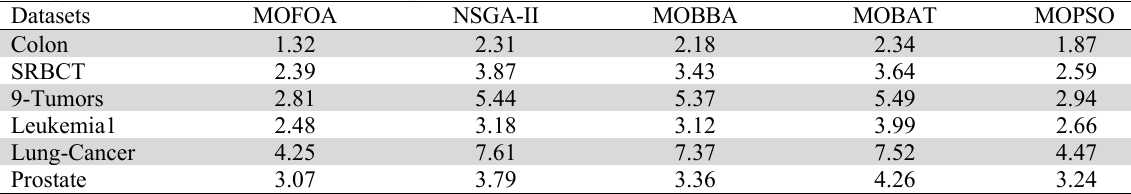
Comparison of results based on computational time (in minutes) Datasets